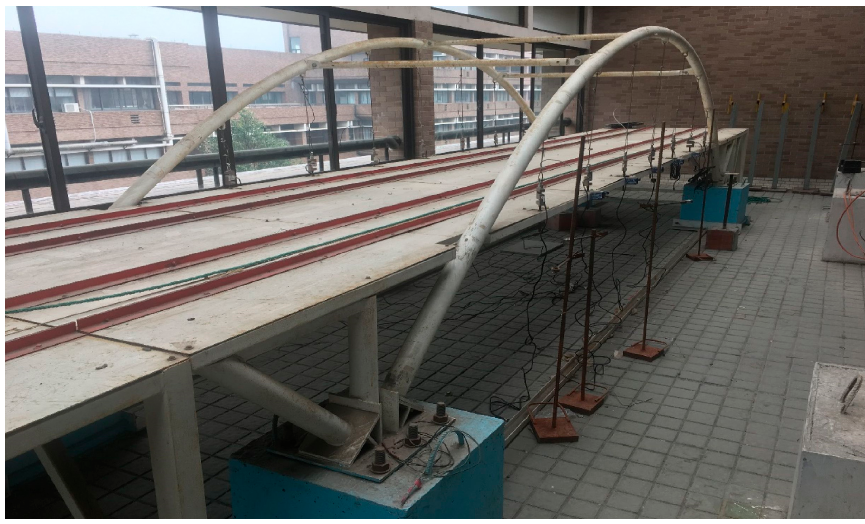
Figure 7. The arch cable bridge lab model built at Zhejiang University Laboratory.